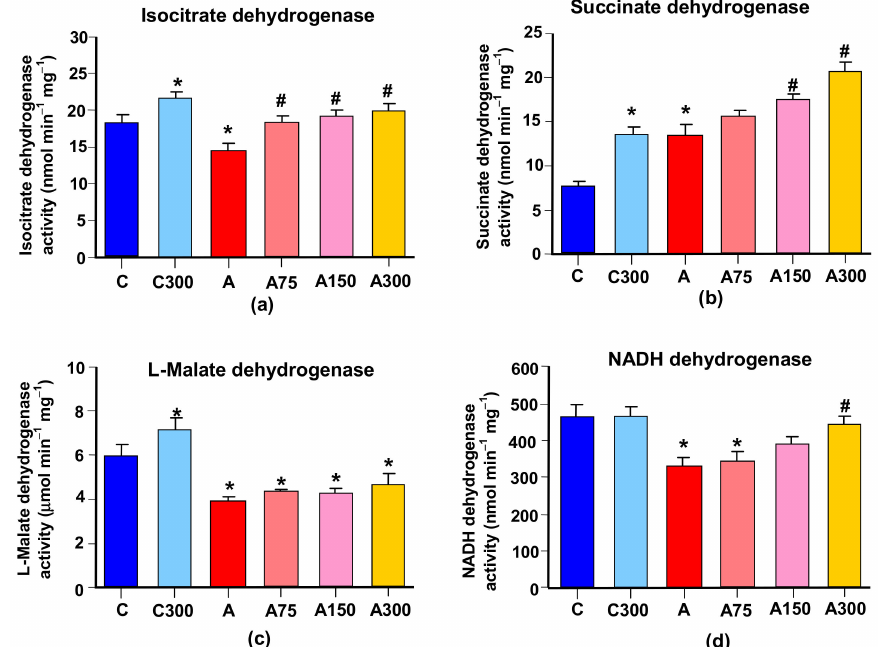
Figure 5. E ff ects of MeJA treatment on selected mitochondrial enzyme activities. ( a ) Succinate dehydrogenase; ( b ) isocitrate dehydrogenase; ( c ) L-malate dehydrogenase; ( d ) NADH dehydrogenase. Abbreviations: C, controls; C300, controls treated with 300 mg / kg MeJA; A, arthritic rats; A75, A150 and A300, arthritic rats treated with 75, 150 and 300 mg / kg MeJA, respectively; A IBU , arthritic rats treated with 30 mg / kg ibuprofen. Data are the means ± standard errors of the mean of five animals for each experimental condition. Statistical analysis: ANOVA one-way with Newman–Keuls post-hoc testing. * p < 0.05, di ff erent from the controls (C); # p < 0.05, di ff erent from non-treated arthritic rats